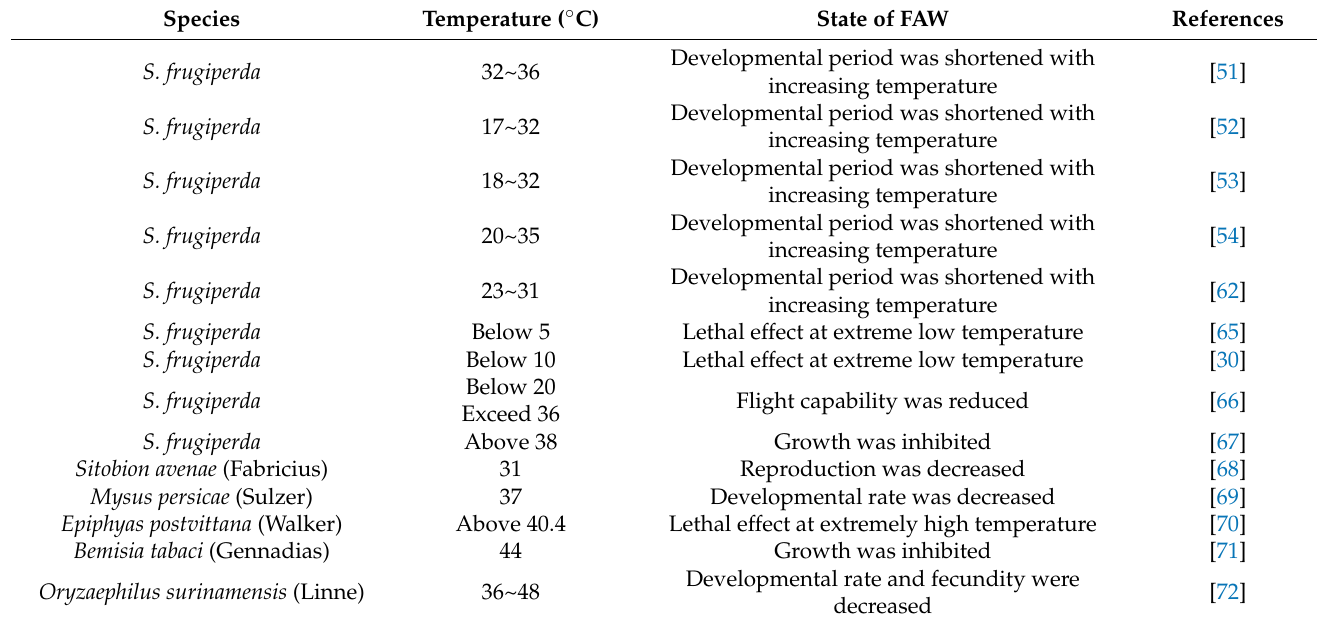
Table 2. The detrimental effect of temperatures on FAW and other